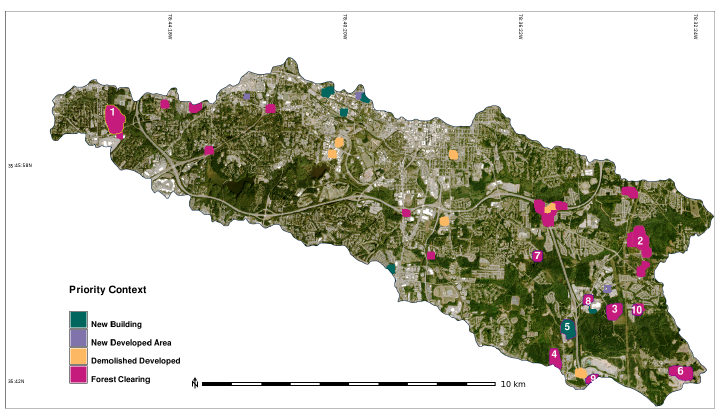
Figure 8. The top ten priority areas labeled with additional context to the type of change that occurred at each